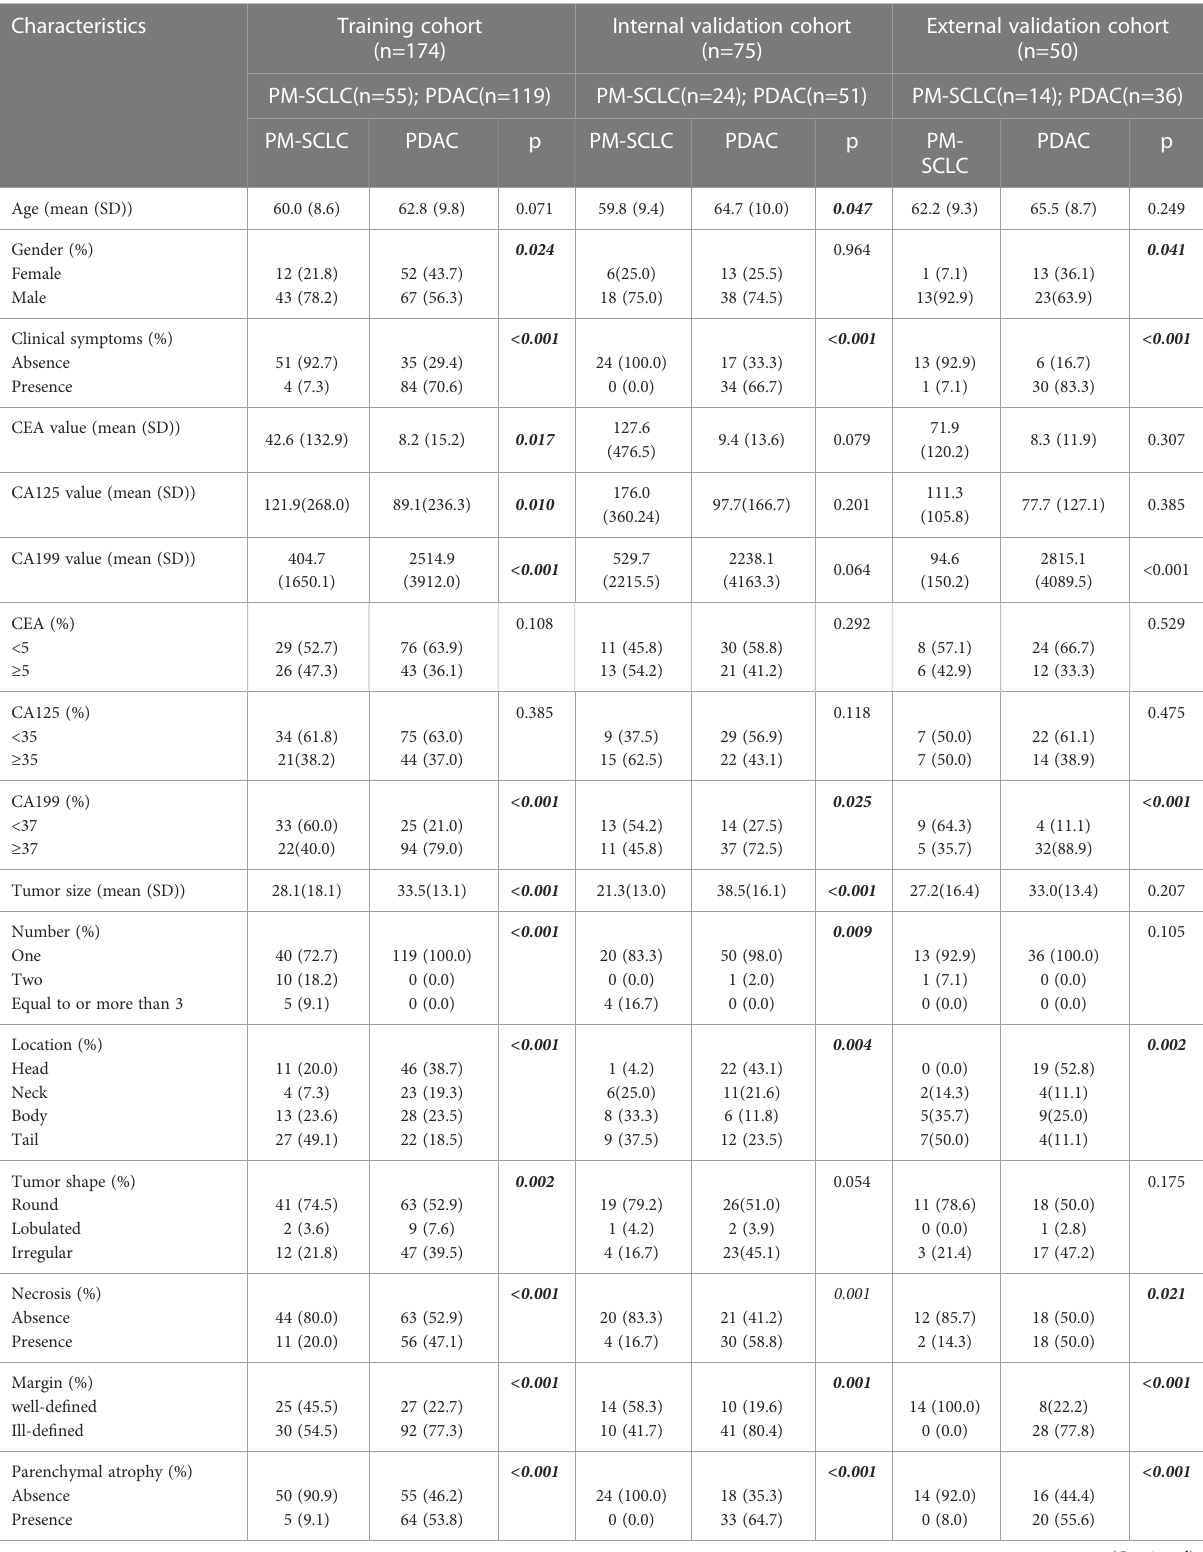
TABLE 2 Comparison of patient characteristics between PM-SCLC and PDAC groups in the three cohorts.